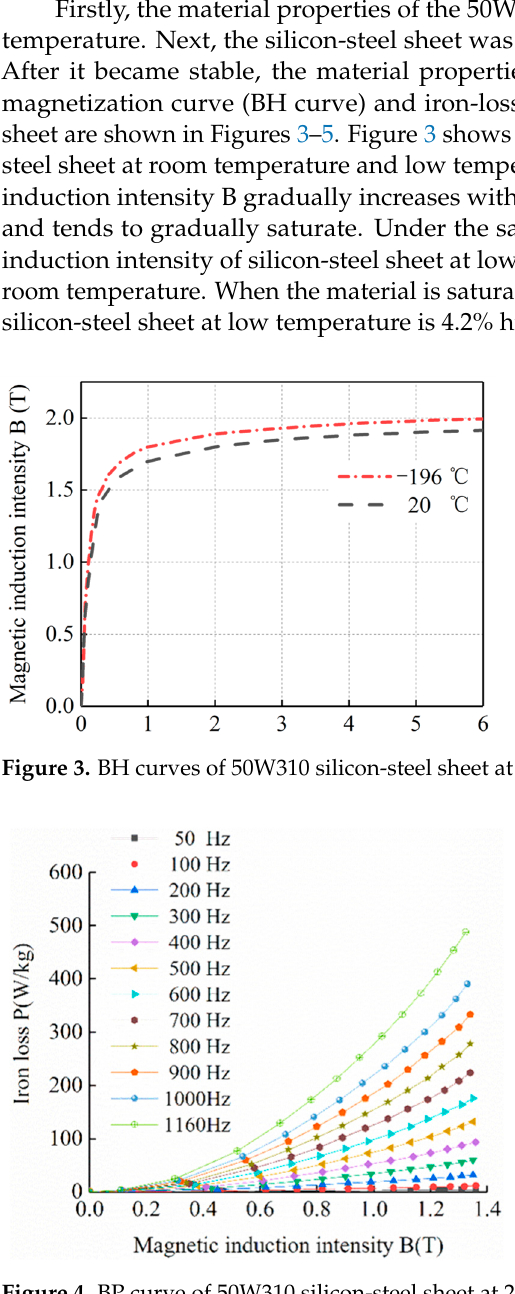
Figure 4. BP curve of 50W310 silicon-steel sheet at 20 °C.